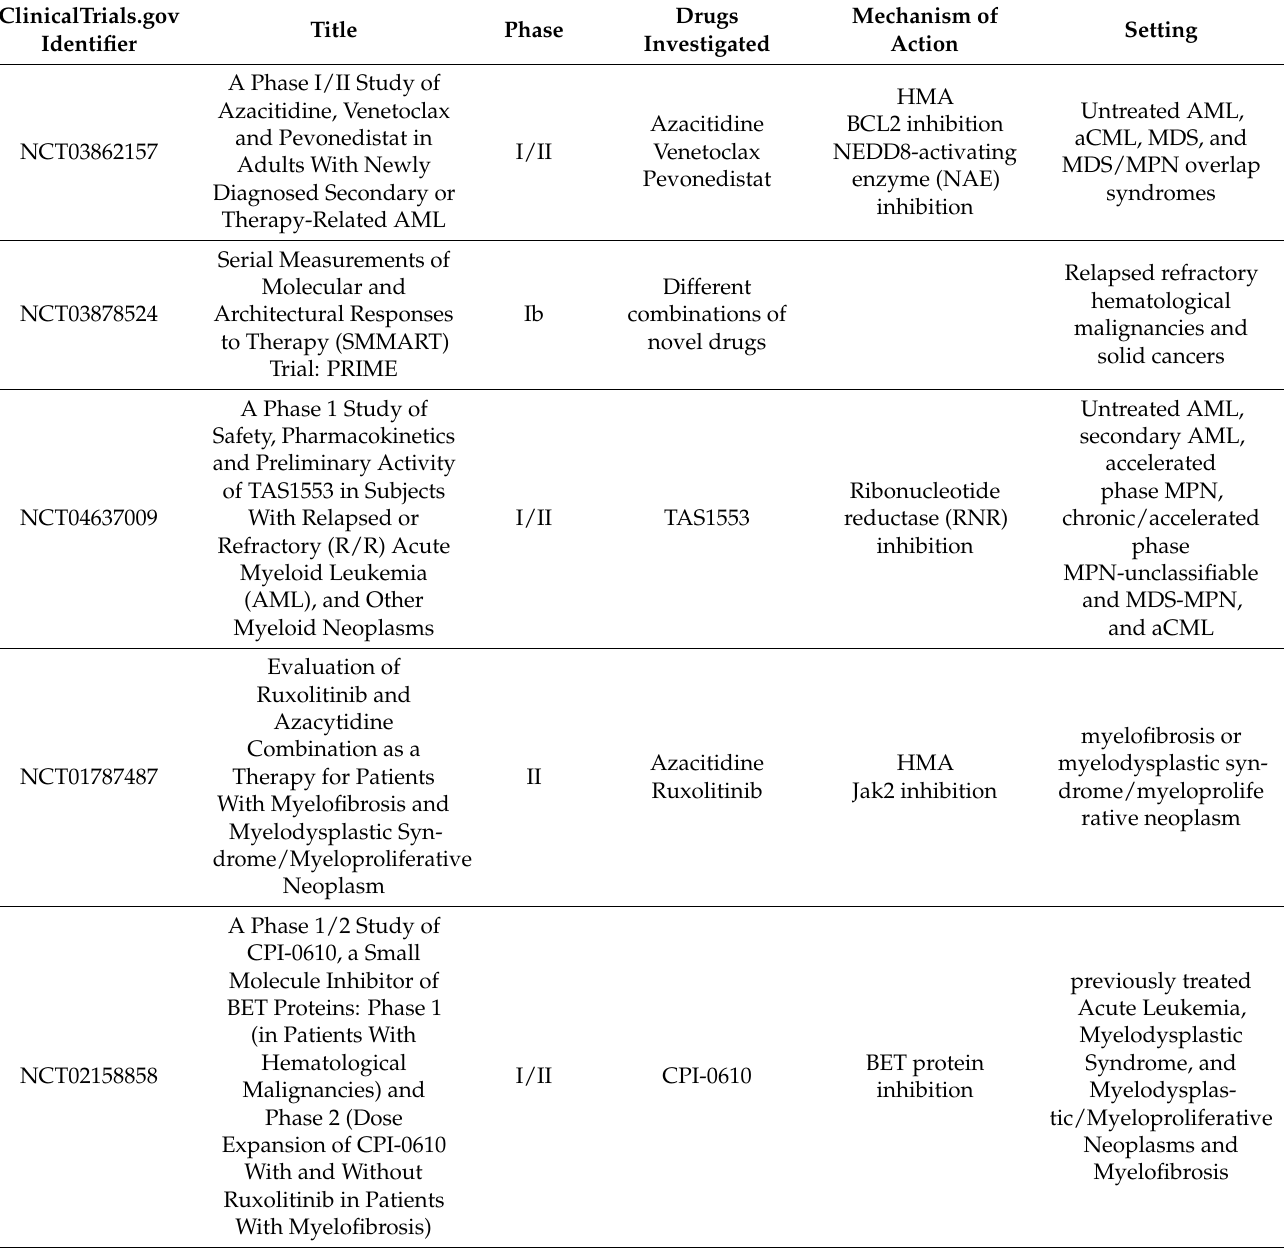
Table 2. Active recruiting clinical trials including Atypical Chronic Myeloid Leukemia (aCML) patients. HMA: hypomethy- lating agents; AML: Acute Myeloid Leukemia; MDS: myelodysplastic disease; MPN: myeloprolipherative neoplasm; and aCML: atypical Chronic Myeloid